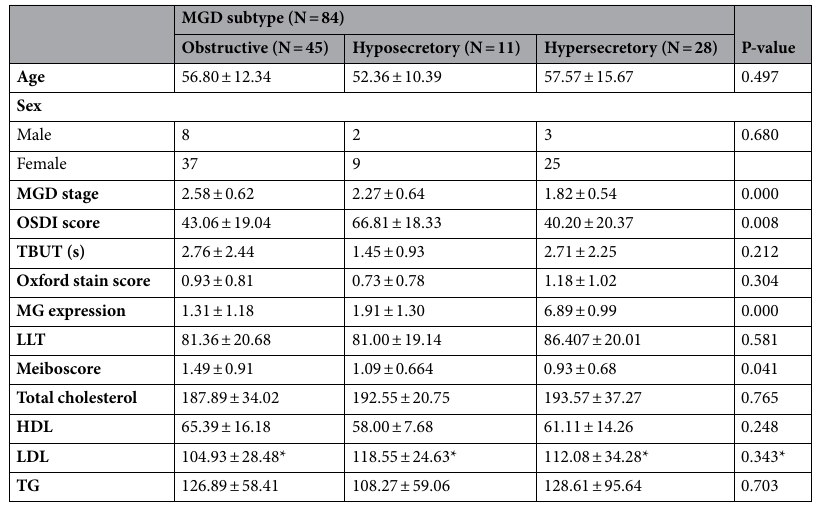
Table 4. Comparison of patient characteristics and serum lipid profile according to MGD subtype. Values are presented as mean ± Standard deviation (range) or number (%). MGD meibomian gland dysfunction, OSDI Ocular surface disease index, MG meibomian gland, LLT lipid layer thickness, TG triglyceride, HDL high- density lipoprotein, LDL Low-density